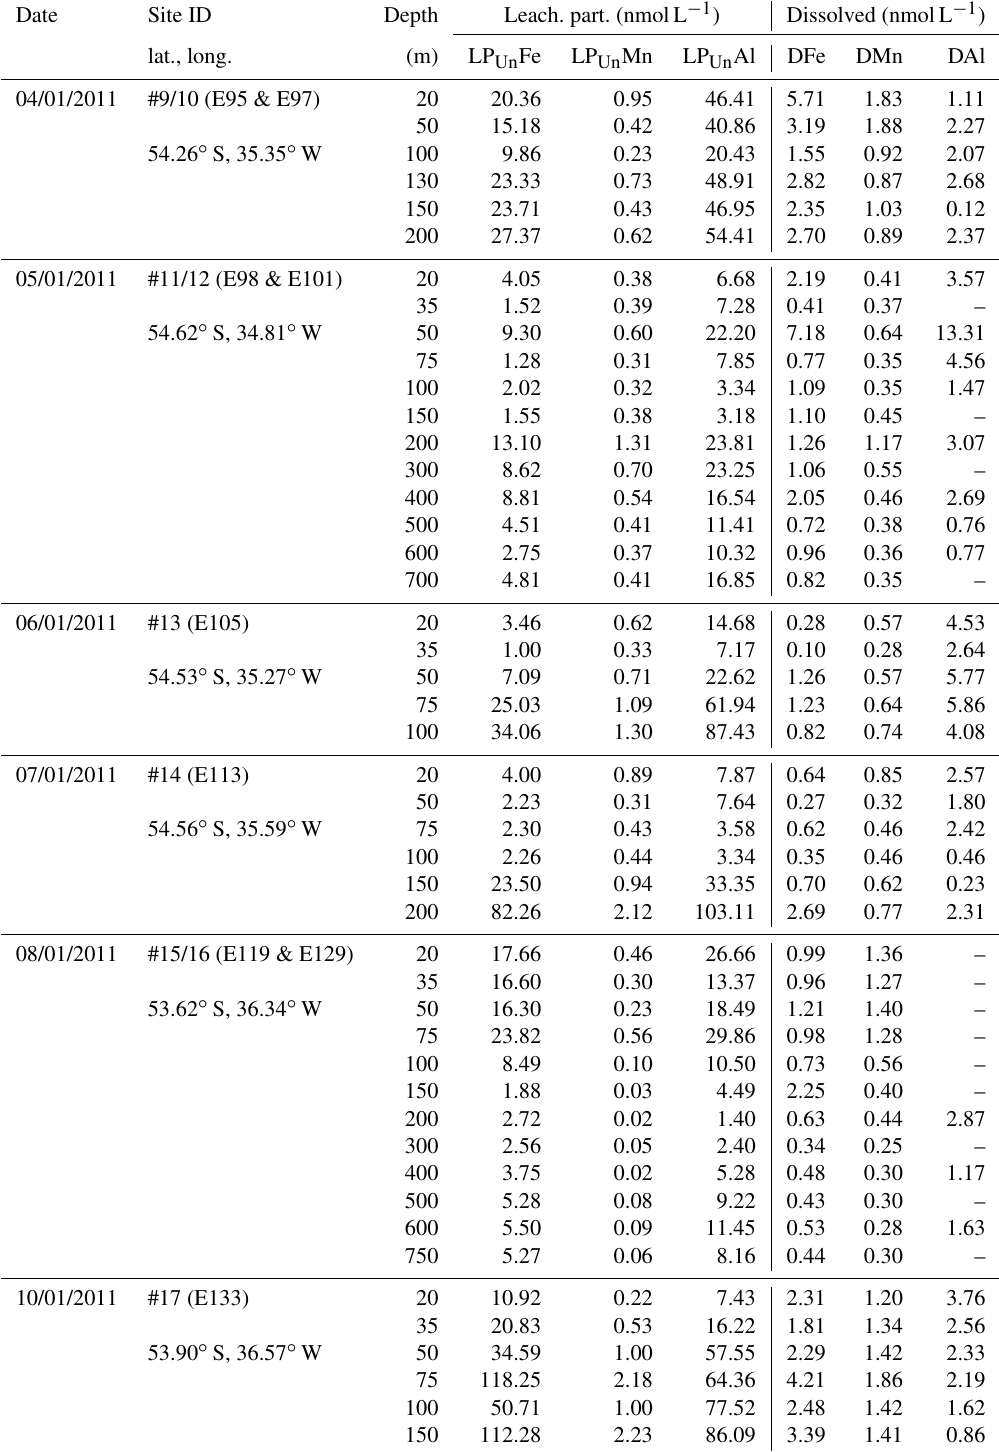
Table 1. OTE seawater samples: Fe, Mn, and Al concentrations determined for the dissolved ( D ) (0.2µm) and the leachable particulate fraction (LP Un ) (total dissolvable–dissolved) of unfiltered seawater samples collected during JR247. Additional information covers sampling date, site (station) ID, event number, and latitude and